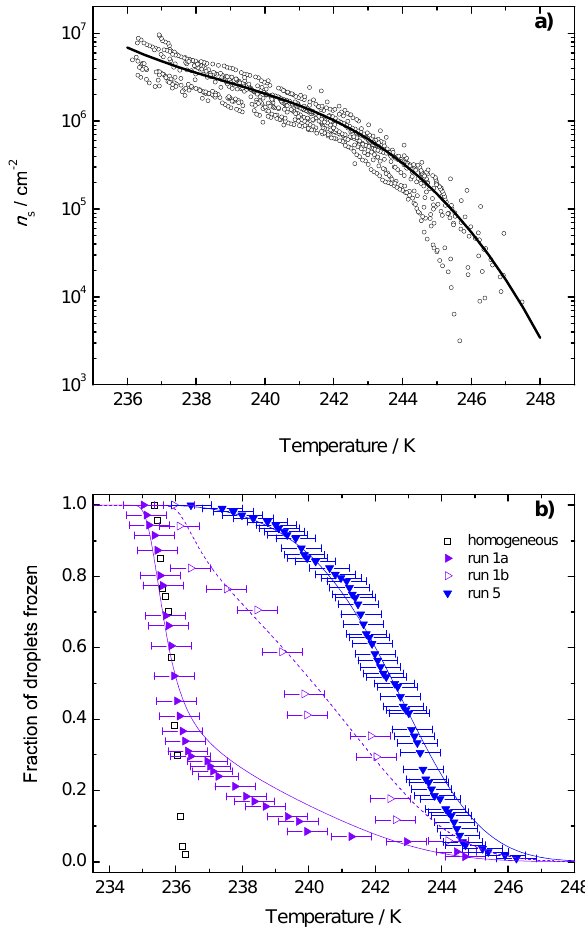
Fig. 15. (a) Fit to ln( n s (T)) for runs with a median surface area of ≤ 2 × 10 − 6 cm 2 (runs 1a–6a, 12a–17a, 1b–2b and 17b). (b) Frac- tion of droplets frozen as a function of temperature for two illite concentrations. The experimental data is compared with our pa- rameterisation (lines, see